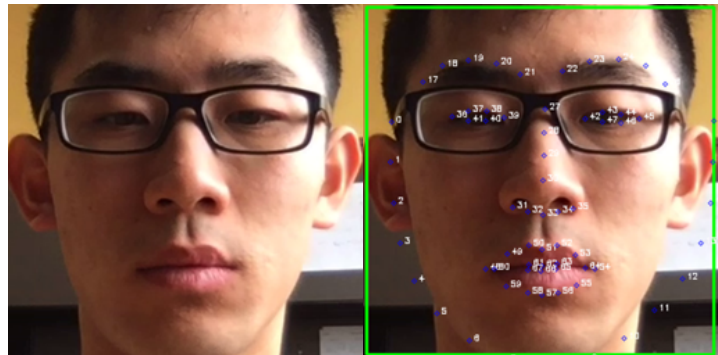
Figure 13. ( left ) Frame of subject 60’s awake video. ( right ) Landmark detection of the frame.